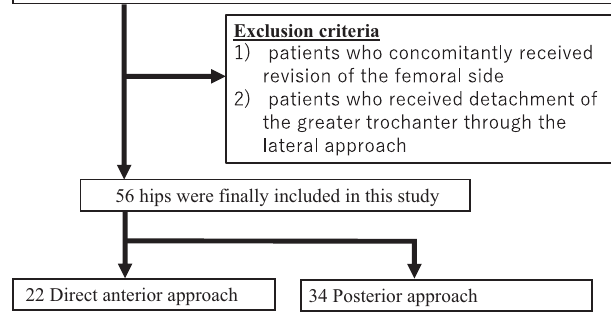
Figure 1. Flow chart of this retrospective Table 1. Demographic characteristic of patients.